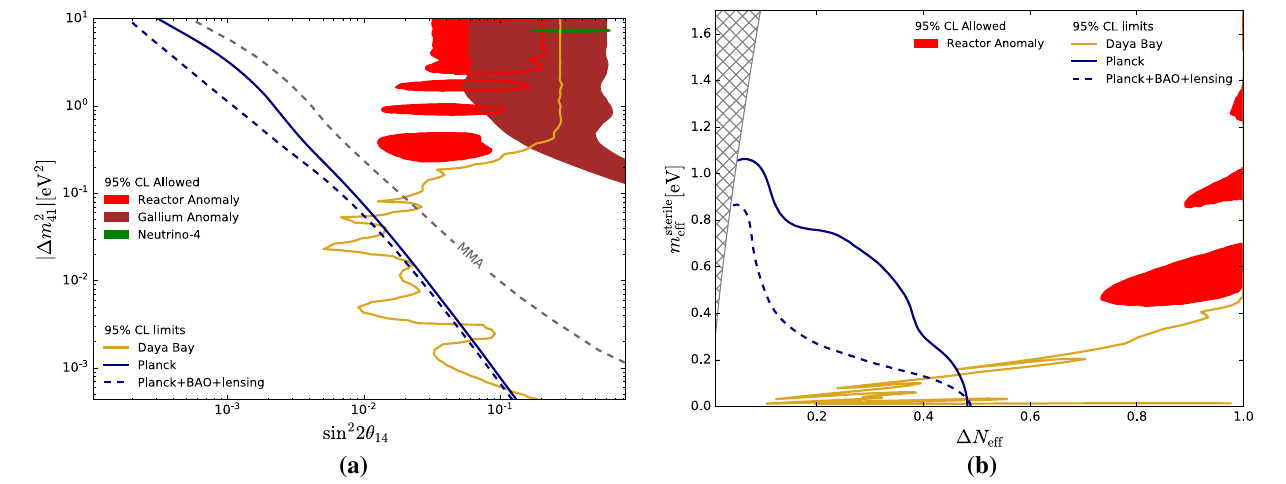
Fig. 2 a Shows, in the neutrino-oscillation parameter space, limits on The dashed blue line shows the impact of further including CMB and the electron flavour mixing with the fourth mass state, using a 1 + 1 BAO data into the Planck limit, again using Eq. 8. The dashed grey line model. The exclusion region from the Daya Bay oscillation experiment, illustrates the impact on the Planck limit (the solid blue) of using the and the allowed regions from the Neutrino-4 experiment and the reac- mean momentum approximation (MMA). Graph b shows the same set tor anomaly, come from searches for ν e disappearance. The allowed of limits (minus the MMA line) in the cosmological parameter space. The Neutrino-4 and gallium-anomaly lines are no longer visible as they region from the gallium anomaly comes from a search for ν e disappear- are compressed up along the (cid:3) N eff = 1 axis. The hatched region cor- ance. For the Daya Bay line, everything to the right is ruled out at 95% Cl. The solid blue line labeled ‘Planck’ shows the exclusion using the responds to the prior of m 4 < 10 eV assumed in the Planck Planck TT, TE, EE and low-multipole EE power spectra, using Eq. 8 to relate m sterile to m 4 , with the region to the right ruled out at 95% Cl. eff